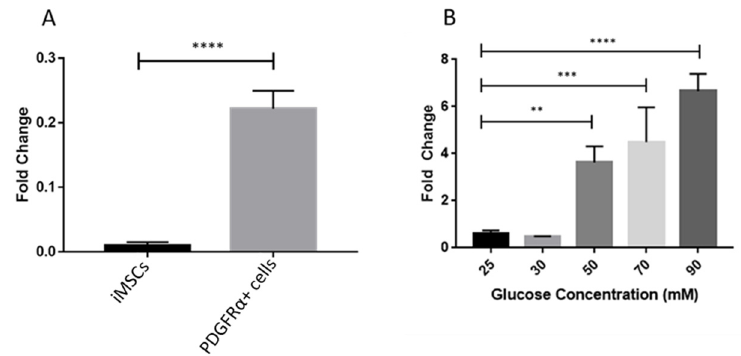
Figure 9. Effects of different glucose concentrations on gene expression of neuronal nitric oxide synthase (nNOS) in PDGFR α -positive cells. ( A ). Under normal concentration of glucose (25 mM), gene expression of nNOS was significantly higher in PDGFR α -positive cells compared to iMSCs. ( B ). Treatment of PDGFR α -positive cells with different concentrations (30, 50, 70, and 90 mM) of glucose produced a significant and concentration-dependent increase in gene expression of nNOS.